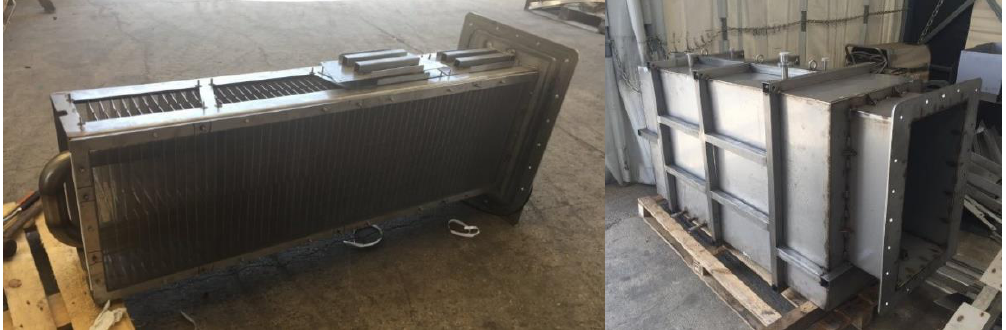
Figure 3. Views of heat exchanger and vacuum chamber.